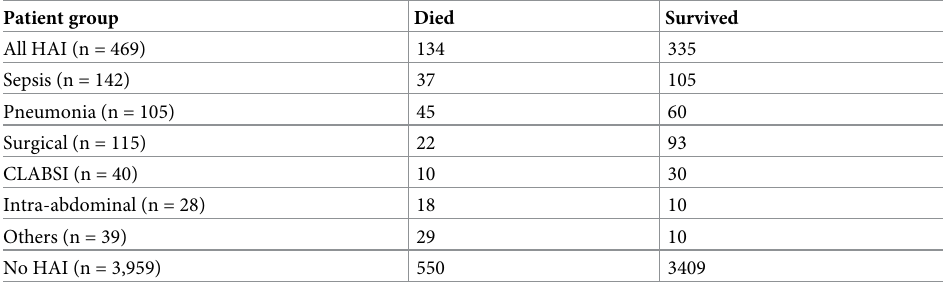
Table 1. Hospital mortality outcomes for those with and without HAI.